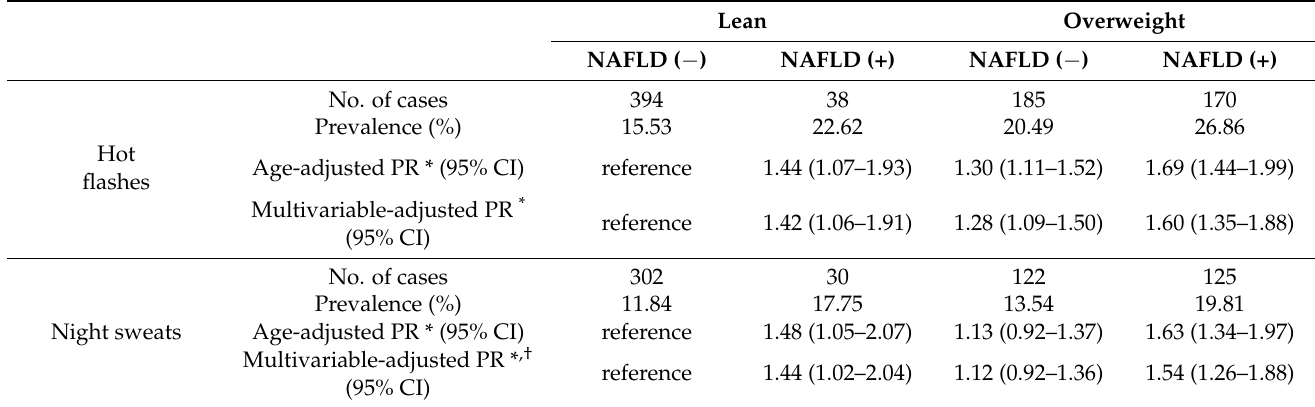
Table 3. Cross-sectional association between nonalcoholic fatty liver disease and vasomotor symp- toms (hot flashes or night sweats) in lean and overweight premenopausal women ( n = 4242). Lean Overweight NAFLD ( − ) NAFLD (+) NAFLD ( − ) NAFLD